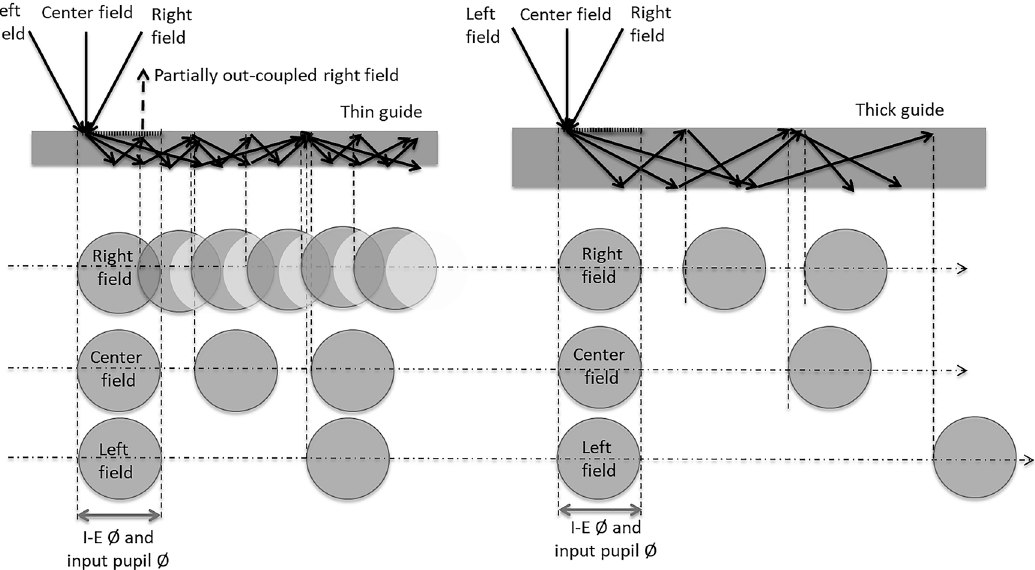
Figure 31: Effects of the input pupil size (and size of the I-E) and thickness of guide on a single field TIR pupil bouncing down the guide.